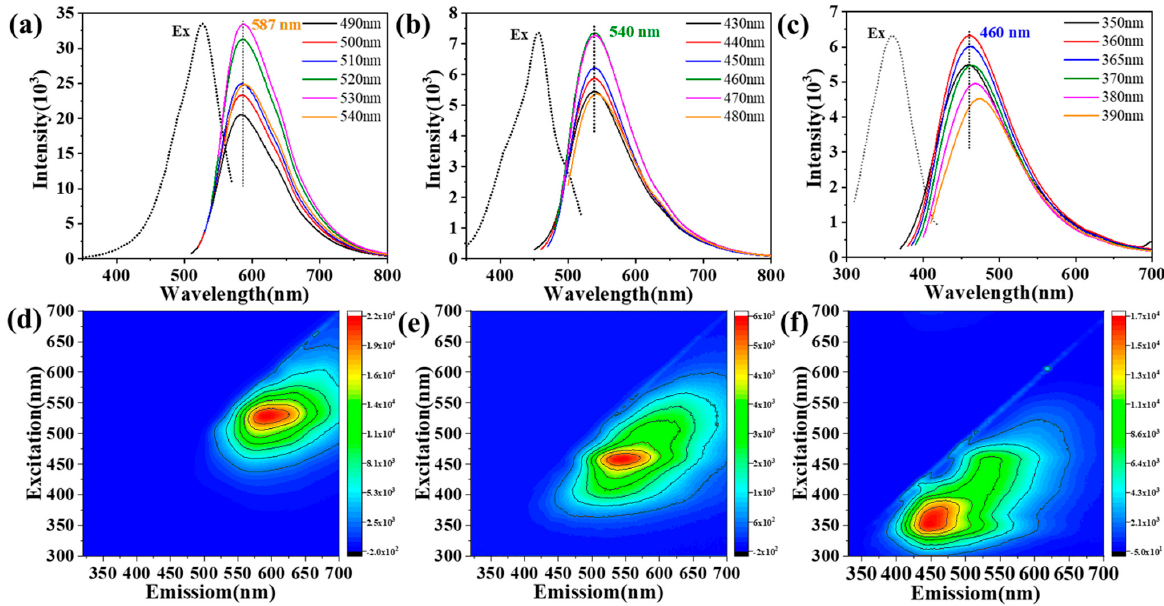
Figure 3. PL emission and excitation spectra of ( a ) R − CDs, ( b ) G − CDs, and ( c ) B − CDs in ethanol (0.1 mg/mL) at different excitation wavelengths. 3D fluorescence (FL) spectroscopy analyses of ( d ) R − CDs, ( e ) G − CDs, and ( f ) B − CDs.